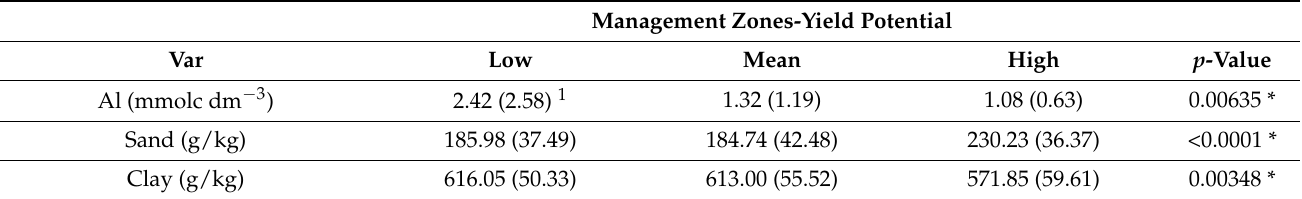
Table 2. Analysis of variance for soil attributes (0–0.20 m) in each of the management